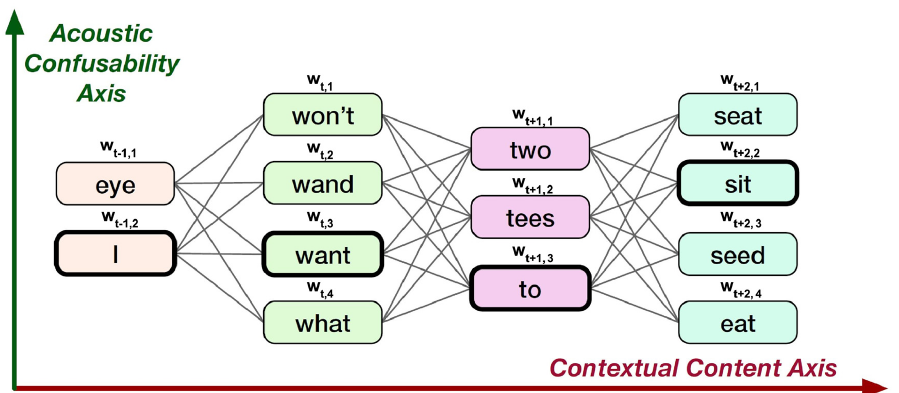
Fig 1. Example confusion network output by ASR for the ground-truth phrase—“I want to sit”. Figure adapted from P. G. Shivakumar and P. Georgiou, “Confusion2vec: Towards enriching vector space word representations with representational ambiguities,” PeerJ Computer Science, vol. 5, p. e195, 2019 [10].